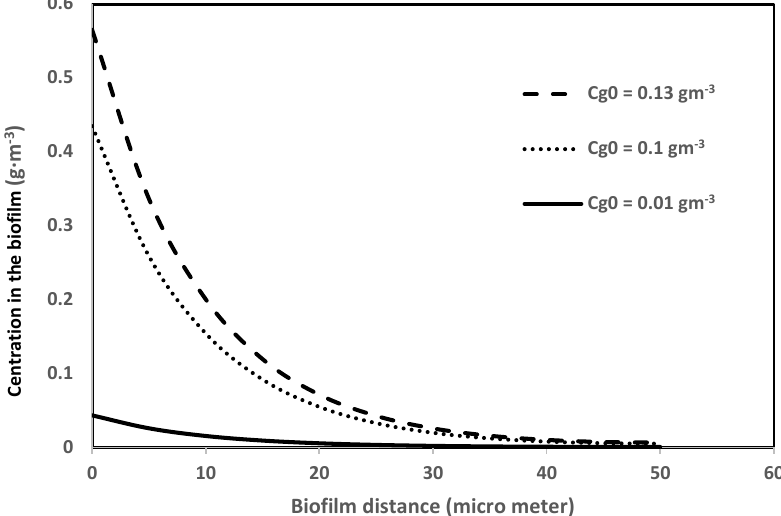
Figure 5. Concentration profiles of benzene in the biofilm in a steady state.